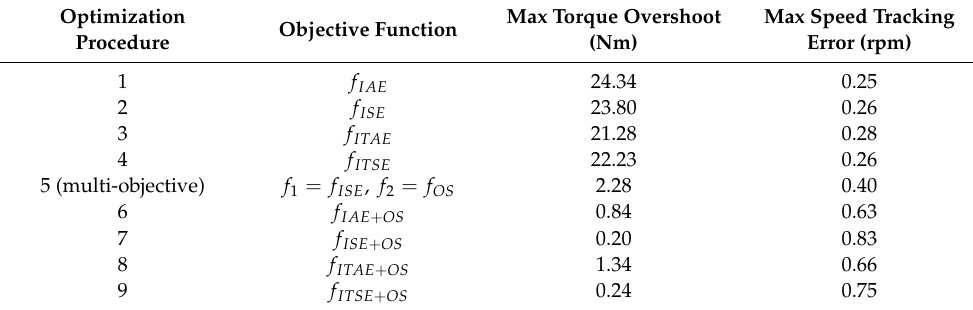
Table 3. Optimization results.